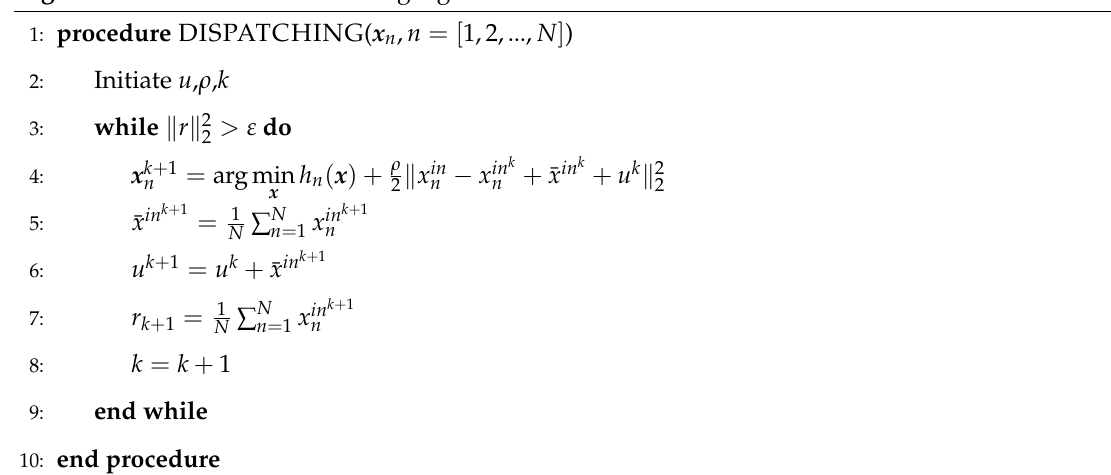
Algorithm 1 Distributed scheduling